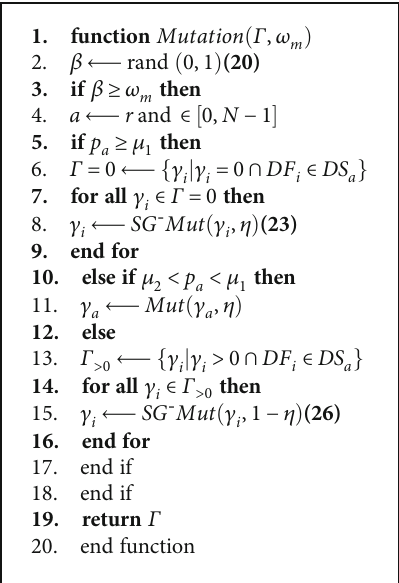
Algorithm 3: The mutation